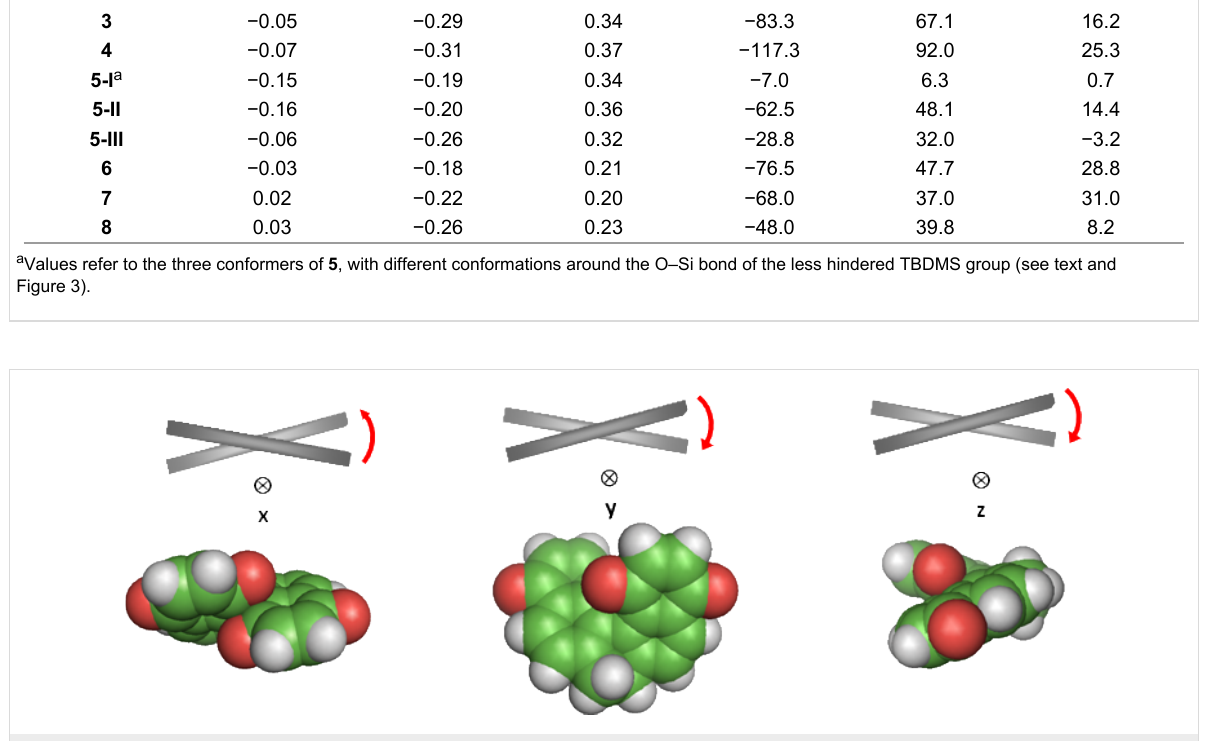
Figure 4: Helicity of the molecular surface of derivative 1 along its principal alignment axes in the liquid crystal